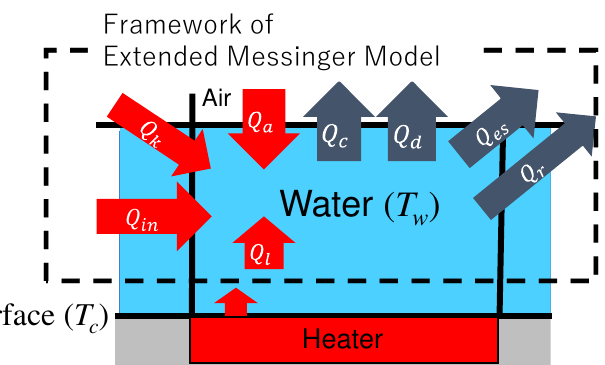
Figure 3. Concept of the thermodynamic model based on the energy balance in a computational cell. The energies into and out of the cell are indicated by the red and dark blue arrows, respectively.